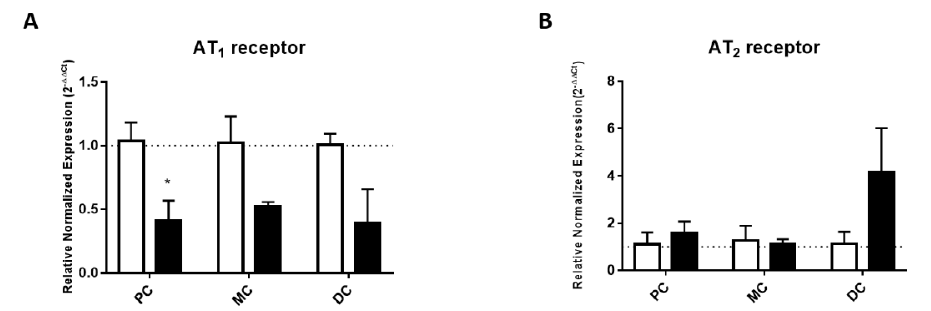
Figure 5. Relative normalized expression (2 − ∆∆ C t ) of ( A ) AT 1 (PC: n = 3, MC: n = 2; DC: n = 3) and ( B ) AT 2 (PC: n = 2; MC: n = 3; DC: n = 2) receptors in the controls (white bars) and TNBS-induced (black bars) animals. * p < 0.05 vs. corresponding control group.